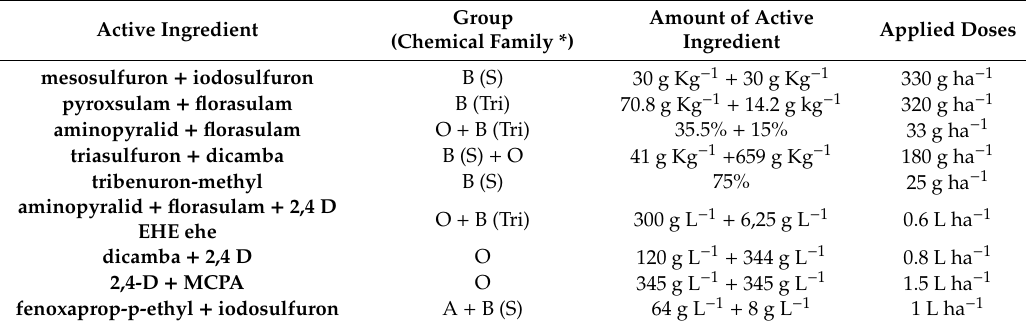
Table 7. Herbicide treatments tested in field